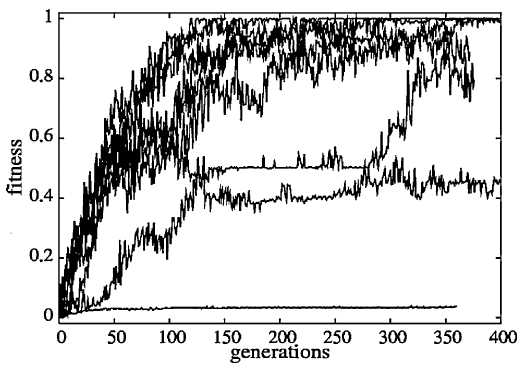
Figure 5. The fitness of the best individual throughout generations for 10 replications of the experiment.